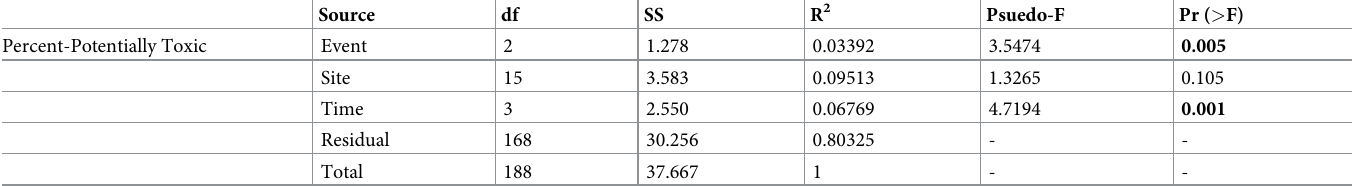
Table 7. PERMANOVA of percentage of potentially-toxic Microcystis based on sites (1.1–15.1), event (November 2014, April 2015, November 2015, and April 2016), and time point (initial sediment, t 2 , t 4 , t 6 ). Tests were based on the non-Euclidean Bray-Curtis dissimilarity measure and were done using 999 permutations under the reduced model. Bold values indicate significant differences at p <